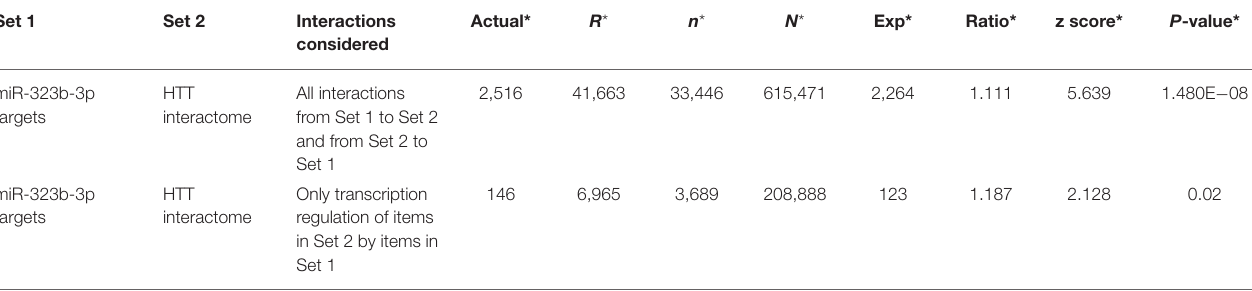
TABLE 3 | Overconnectivity analysis (all interactions and transcription regulation only) between two sets of genes. Set 1 Set 2 Interactions